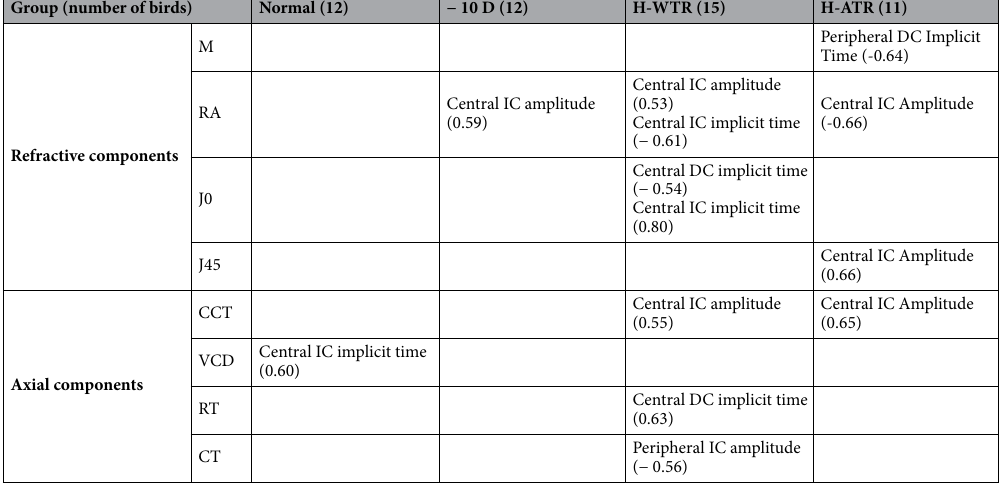
Table 3. Correlations between refractive and axial parameters with retinal responses. Significant correlations were found between refractive (M, spherical equivalent; RA, refractive astigmatism; J0, refractive J0; and J45, refractive J45) or axial (CCT, Central corneal thickness; RT, retinal thickness; and CT, choroidal thickness) parameters with the amplitude and implicit time of DC and IC responses. Only statistically significant correlations with the MOFO responses are presented in the table.